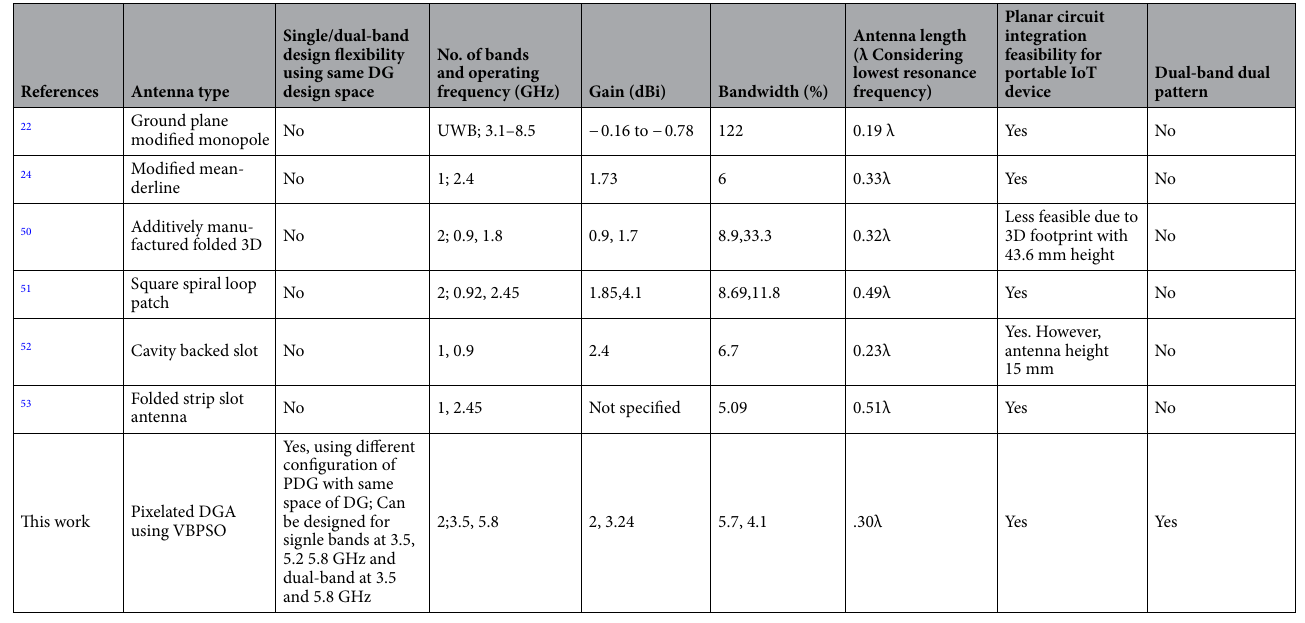
Table 3. Comparison of the proposed PDG antenna with relevant antenna designs prposed for IOT